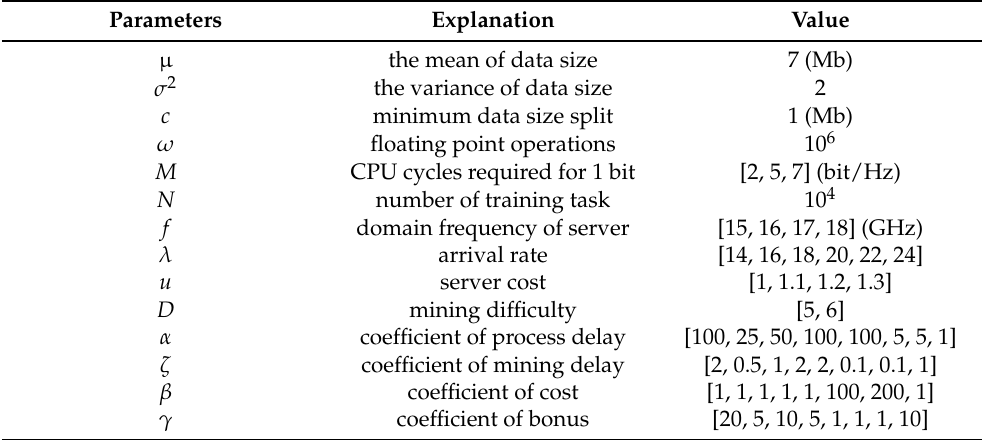
Table 1. Parameter values in